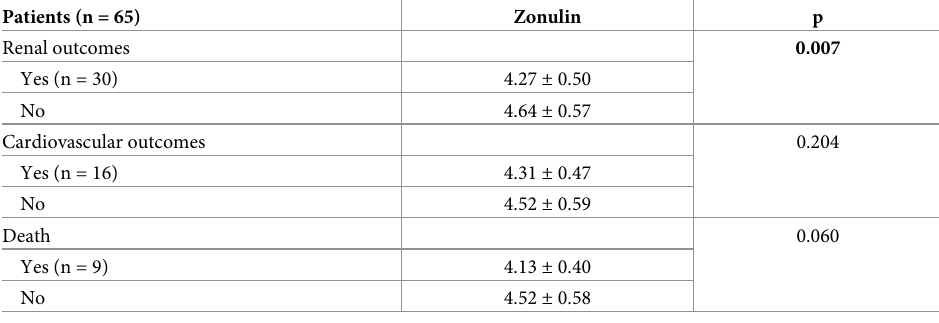
Values are expressed in mean ± standard